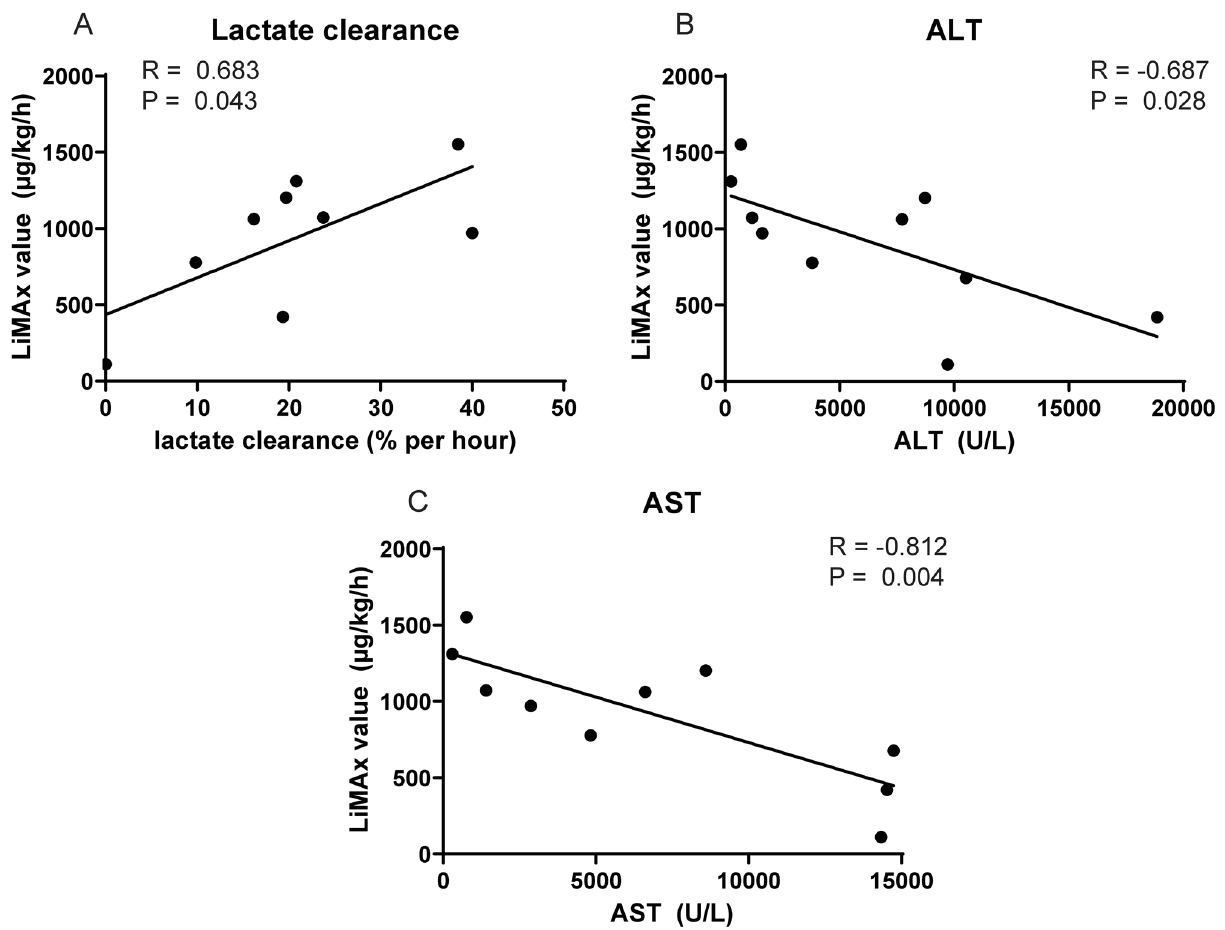
Figure 5. LiMAx value correlates to liver damage biomarkers. ( A ) Displays a significant correlation with lactate clearance. ( B ) Displays a significant correlation between LiMAx and ALT. ( C ) Expresses a significant correlation with